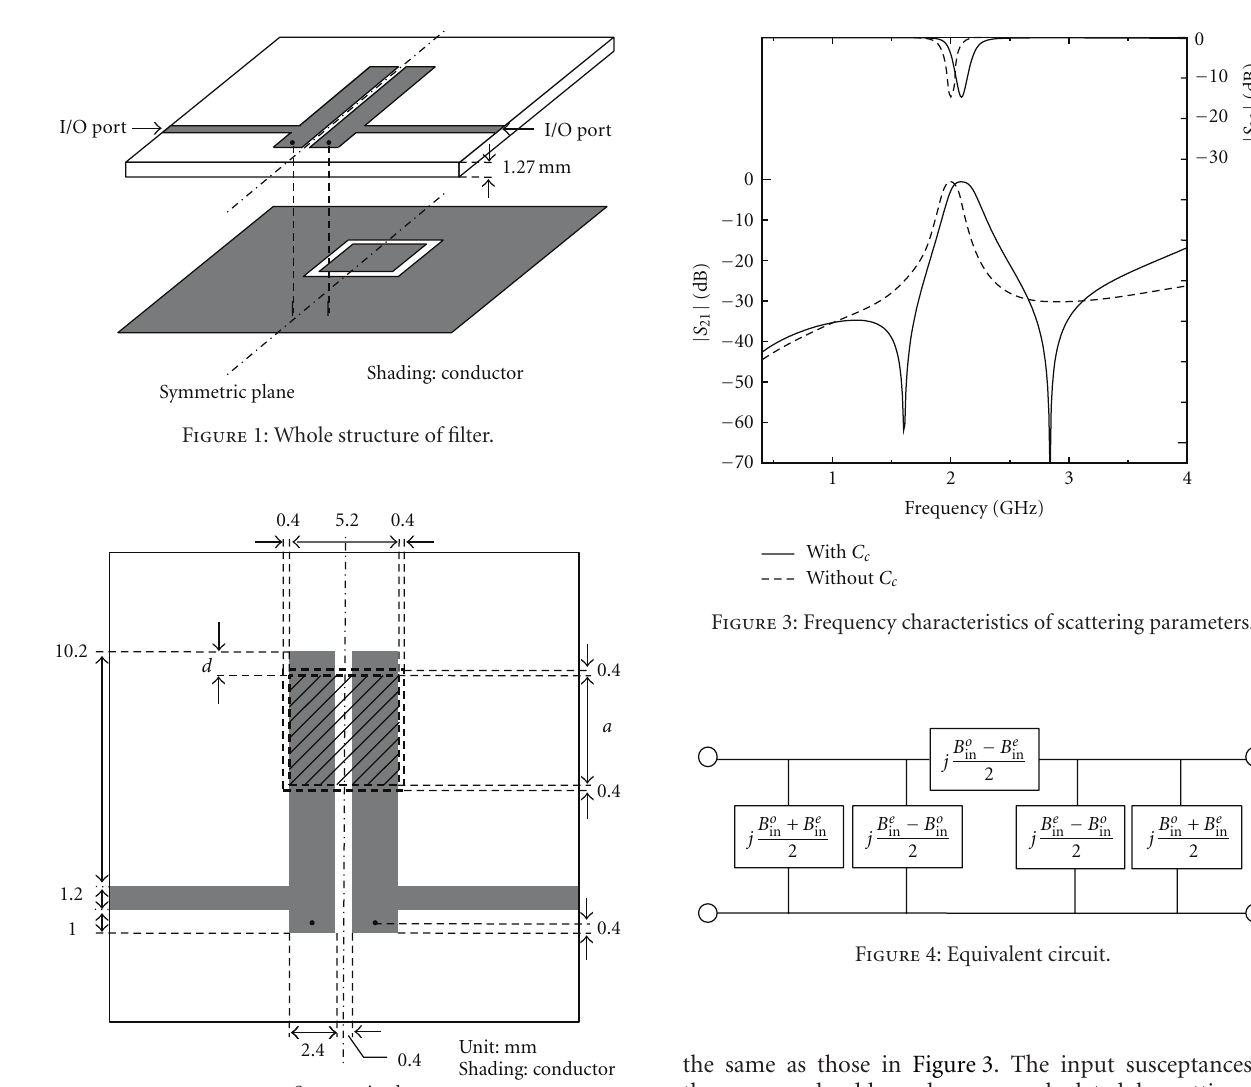
Figure 2: Metallization patterns.